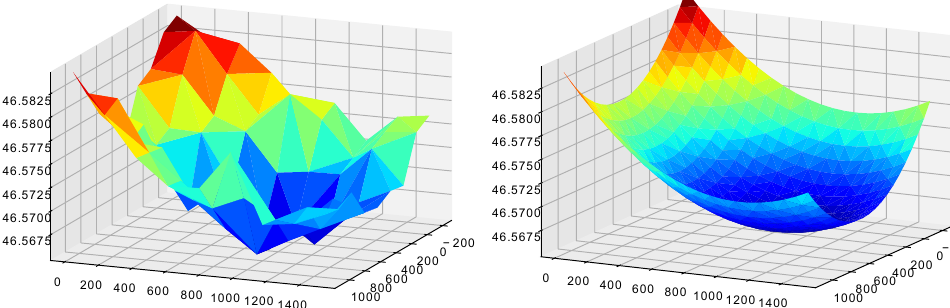
Figure 8. The focus sampling (9 × 9) on the SOI ( left ), and its 3D Gaussian surface approxima- tion ( right